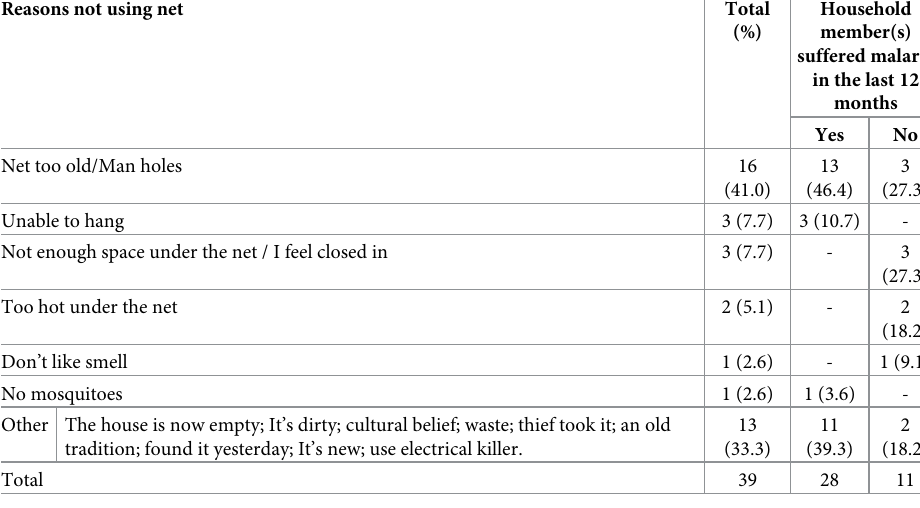
Table 8. Reasons for not using the LLIN amongst household members the night prior to the survey, Mogadishu– Somalia, 2021. Reasons not using